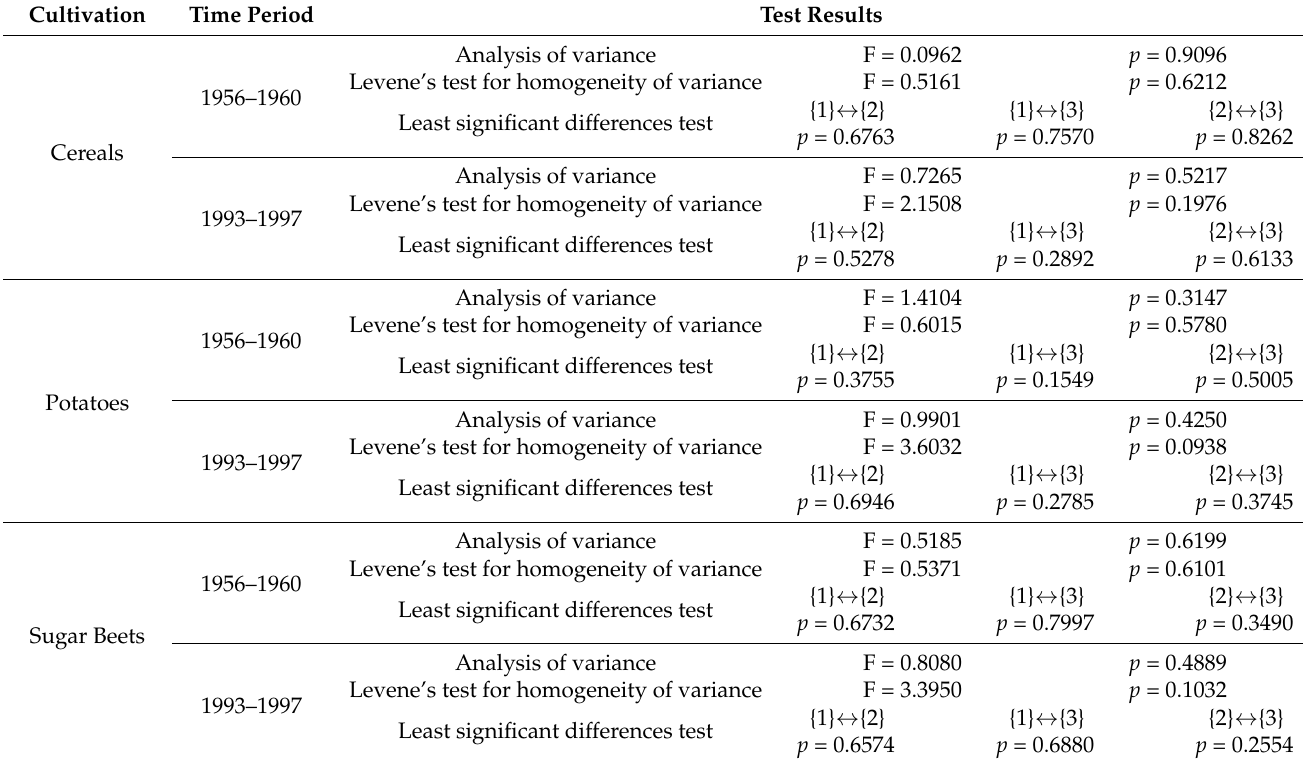
Table 4. Results of the analysis of variance test for significance of differences in yields of selected crops in three groups depending on the distance from the outcrop (according to data from voivodeships) at the beginning and end of the analysis period.